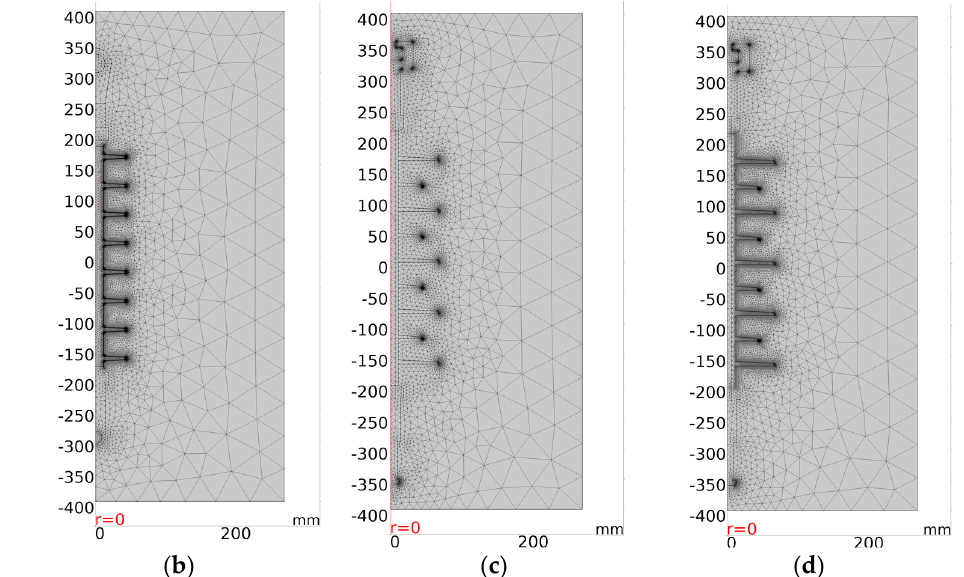
Figure 13. FEM meshing for ( a ) clean type I insulator; ( b ) polluted insulator type I; ( c ) clean insulator type II insulator; ( d ) polluted insulator type II. type II insulator; ( d ) polluted insulator type